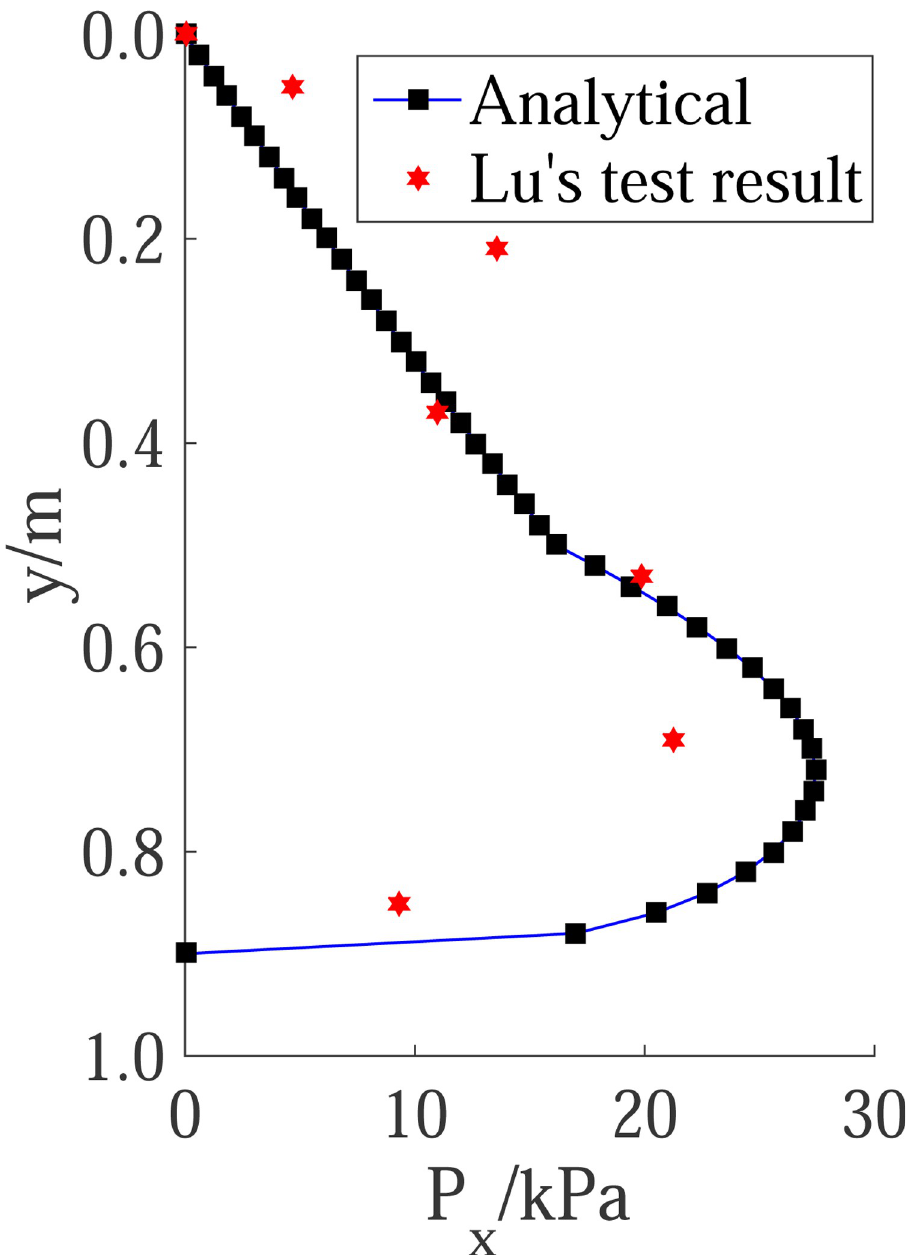
Fig 20. Comparison of passive pressure distribution with Lu’s